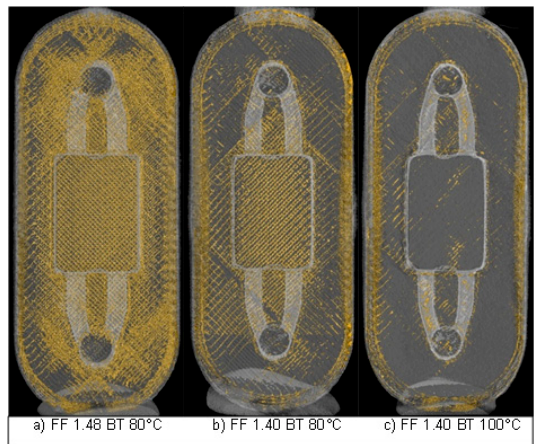
Figure 7. Computer tomographic pore volume analysis with varied form factors (FF) and build chamber temperatures (BT): ( a ) FF 1.48 BT 80 °C; ( b ) FF 1.40 BT 80 °C; ( c ) FF 1.40 BT 100 °C.